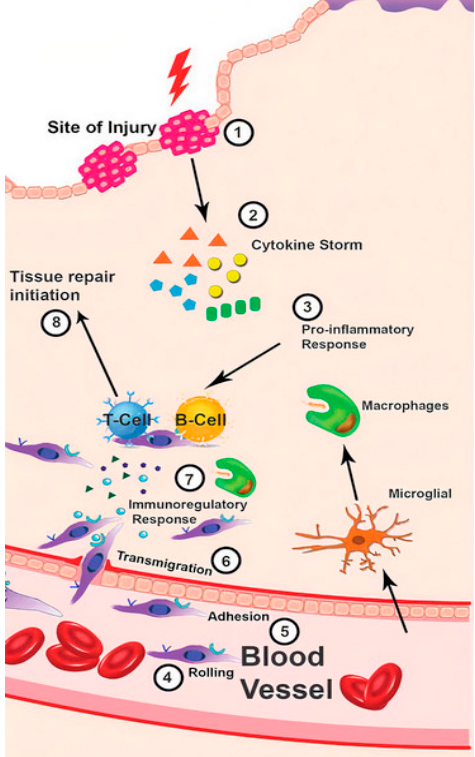
Figure 1. Immune response in wound healing process. Reprinted with permission from Rawat, S. et al. Mesenchymal Stem Cells Modulate the Immune System in Developing Therapeutic Interventions. IntechOpen. Copyright (2019) [35].